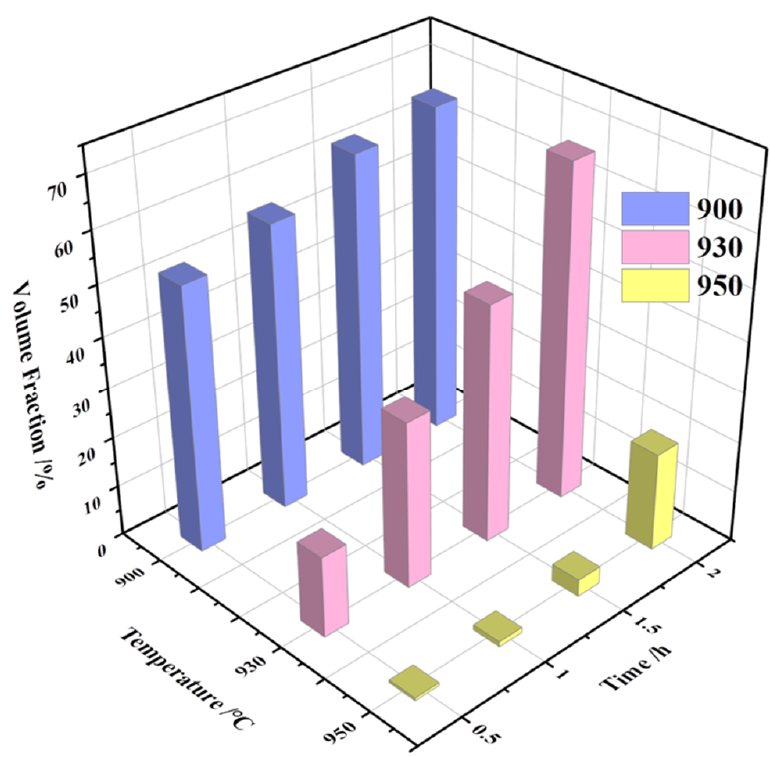
Figure 6. The volume fraction of the acicular O phase varies with temperature and time.